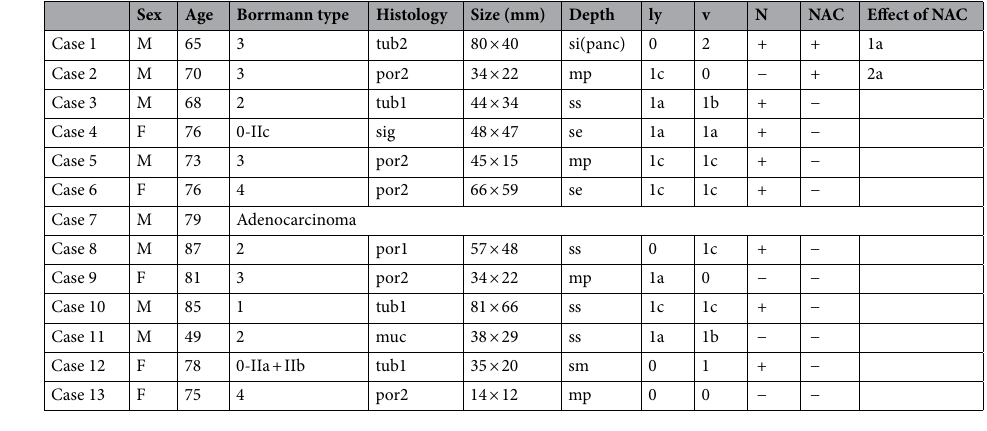
Table 2. Patient characteristics of each case in clinical sample imaging. NAC neoadjuvant chemotherapy.